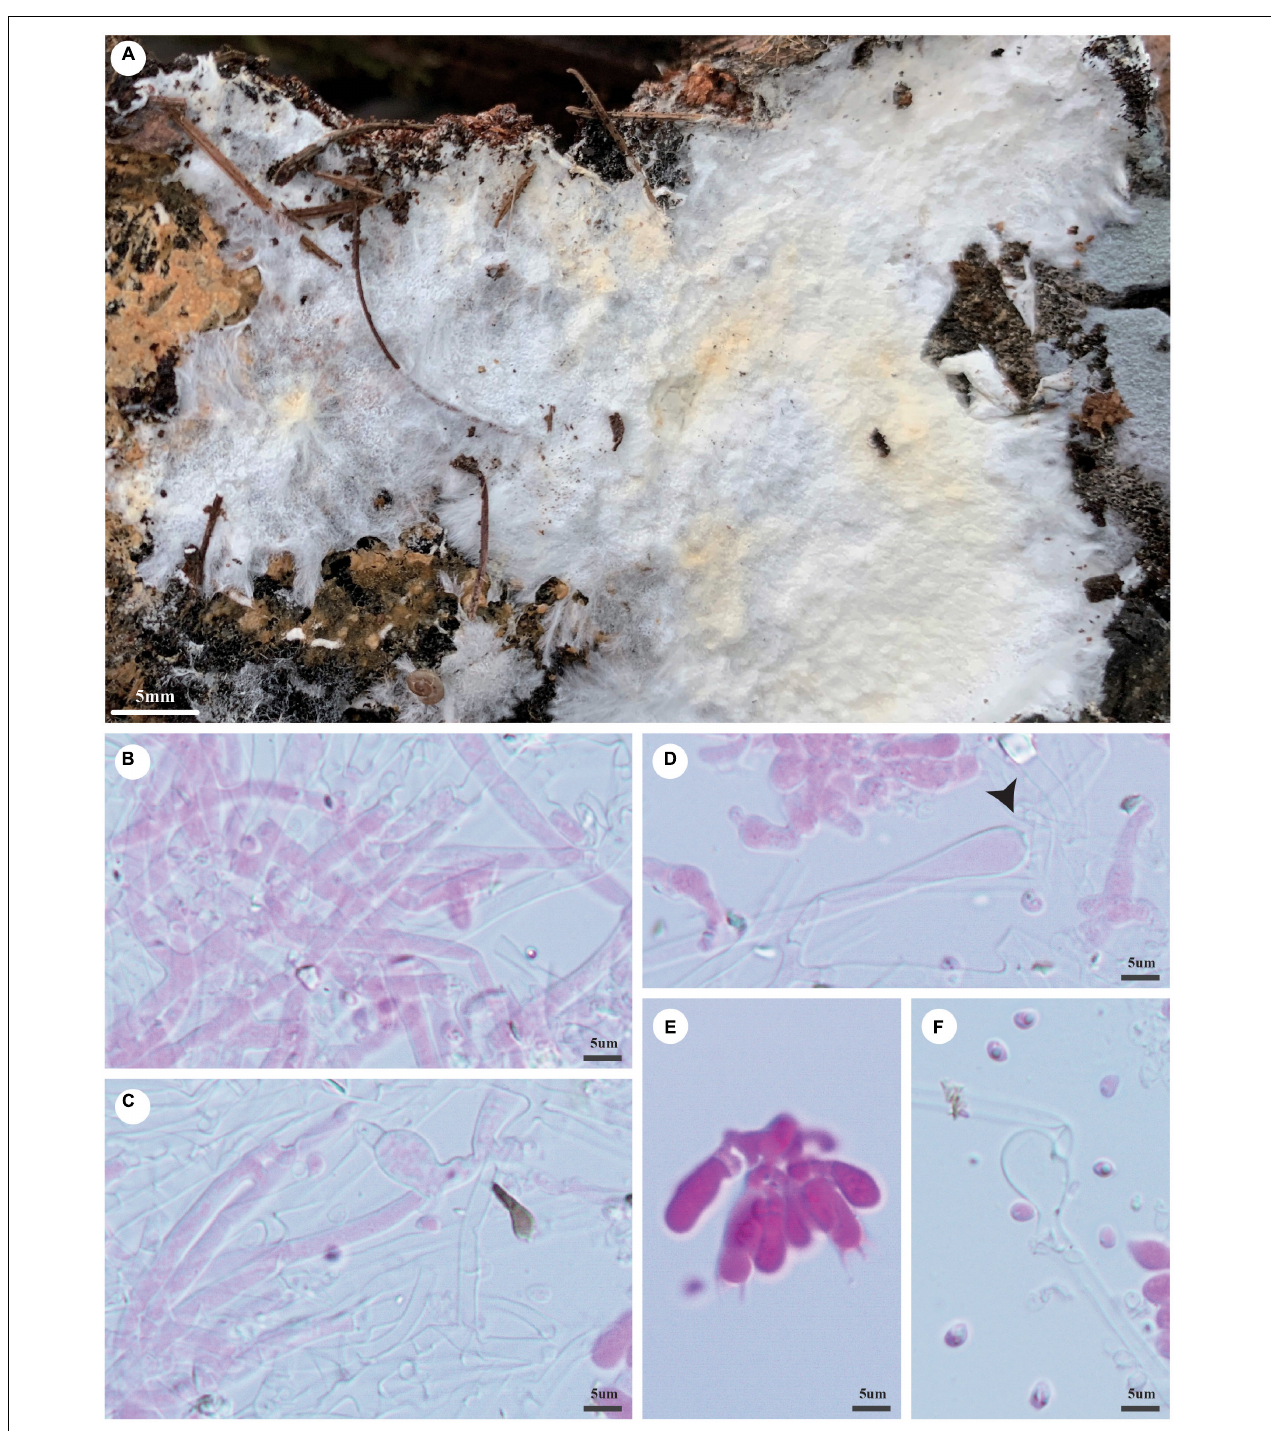
FIGURE 7 | Trechispora laevispora (holotype, Dai 21655). (A) A basidioma, (B,C) hyphae from subiculum, (D) subicular hyphae with ampullate septa (black arrow) and a piece of hymenium, (E) basidia and basidioles, and (F) basidiospores. Photo by Ya-Ping Lian and Zhan-Bo Liu.